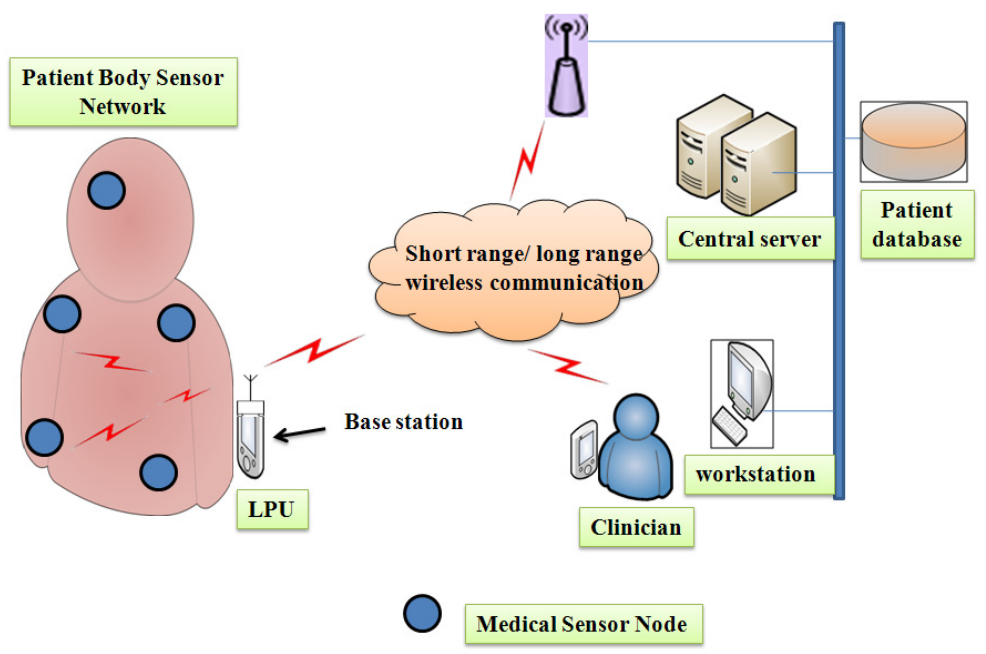
Figure 5. UbiMon system